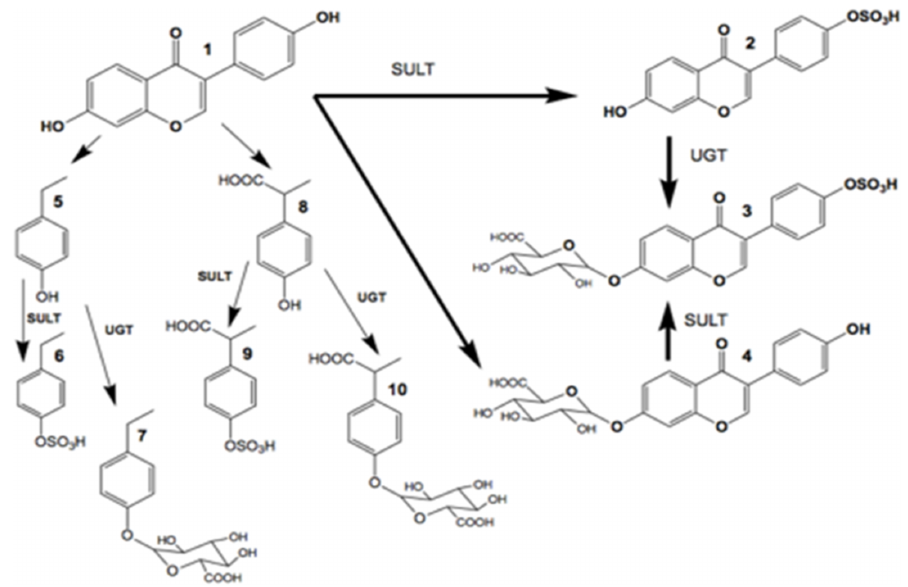
Fig 1. GE metabolism in mice. Schematic drawingof the ways in which GE is metabolized in mice. GE 1 undergoesboth sulfate 2 and glucuronide 4 conjugation, as well as cleavagereactionsto generate 4-ethylphenol 5 and 2-(4-hydroxyphenyl)propionicacid 8 . Both of these cleavedmetabolites undergosulfate 6, 9 and glucuronide conjugation 7, 10 . SULT = 3’-phosphoadenosine5’-phosphosulfatesulfotransferase, UGT = uridine5’-diphospho glucuronosyltransferase.